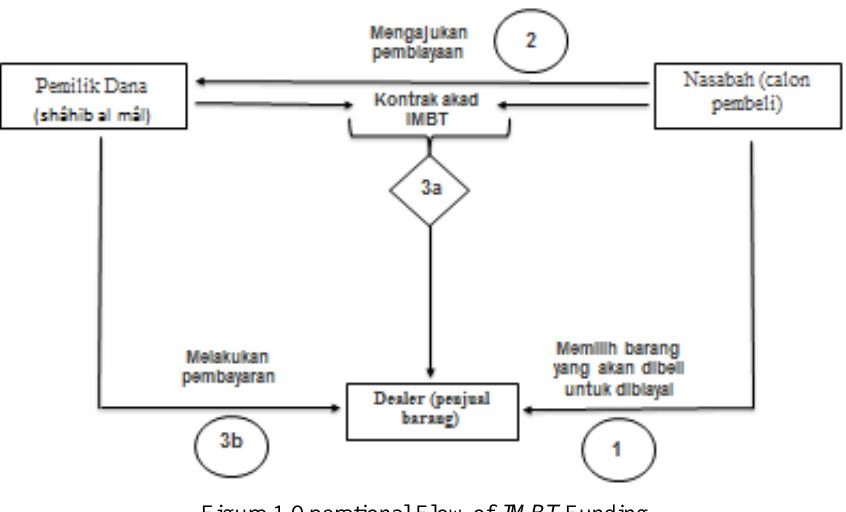
Figure 1 Operational Flow of IMBT